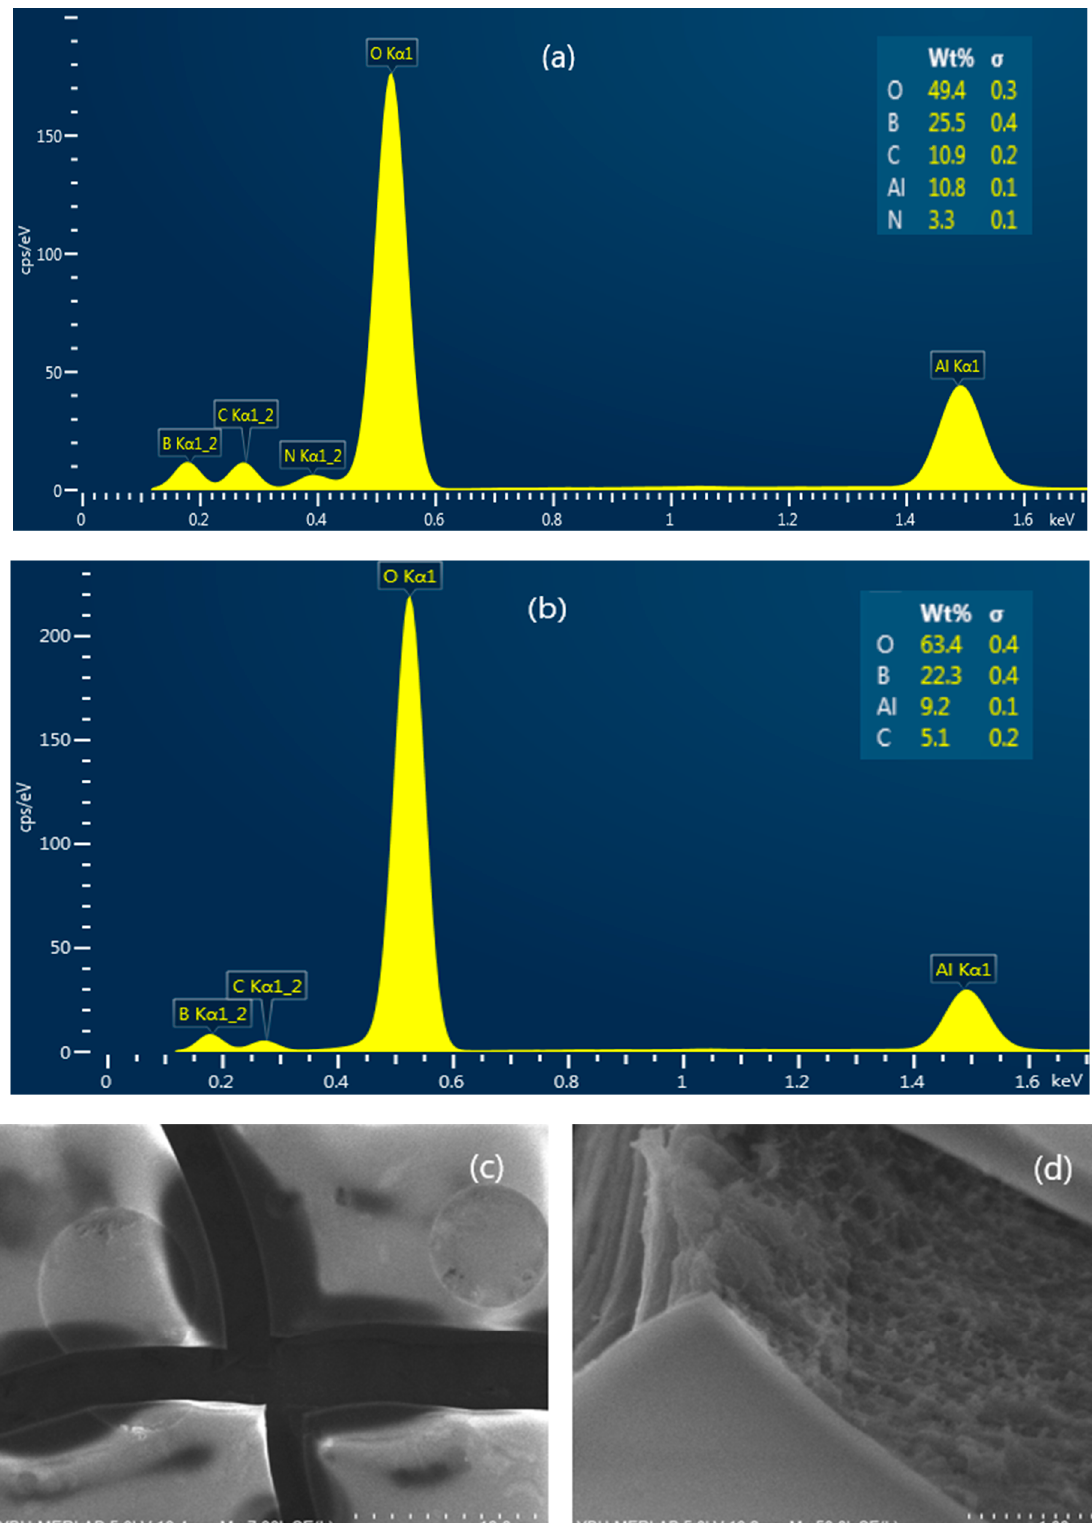
Figure 3. SEM/EDS analysis of DMAB and LiBH 4 hydrolysis products. SEM/EDS data for ( a ) DMAB, ( b ) LiBH 4 , and SEM image for ( c ) DMAB and ( d ) LiBH 4 . SEM analyses of the catalyst surface were performed after the fourth reuse from the hydrolysis reactions. Related images are given in Figure 4. It is observed that the by-prod- uct accumulates locally on the nickel catalyst surface used in DMAB and LiBH 4 hydrolysis